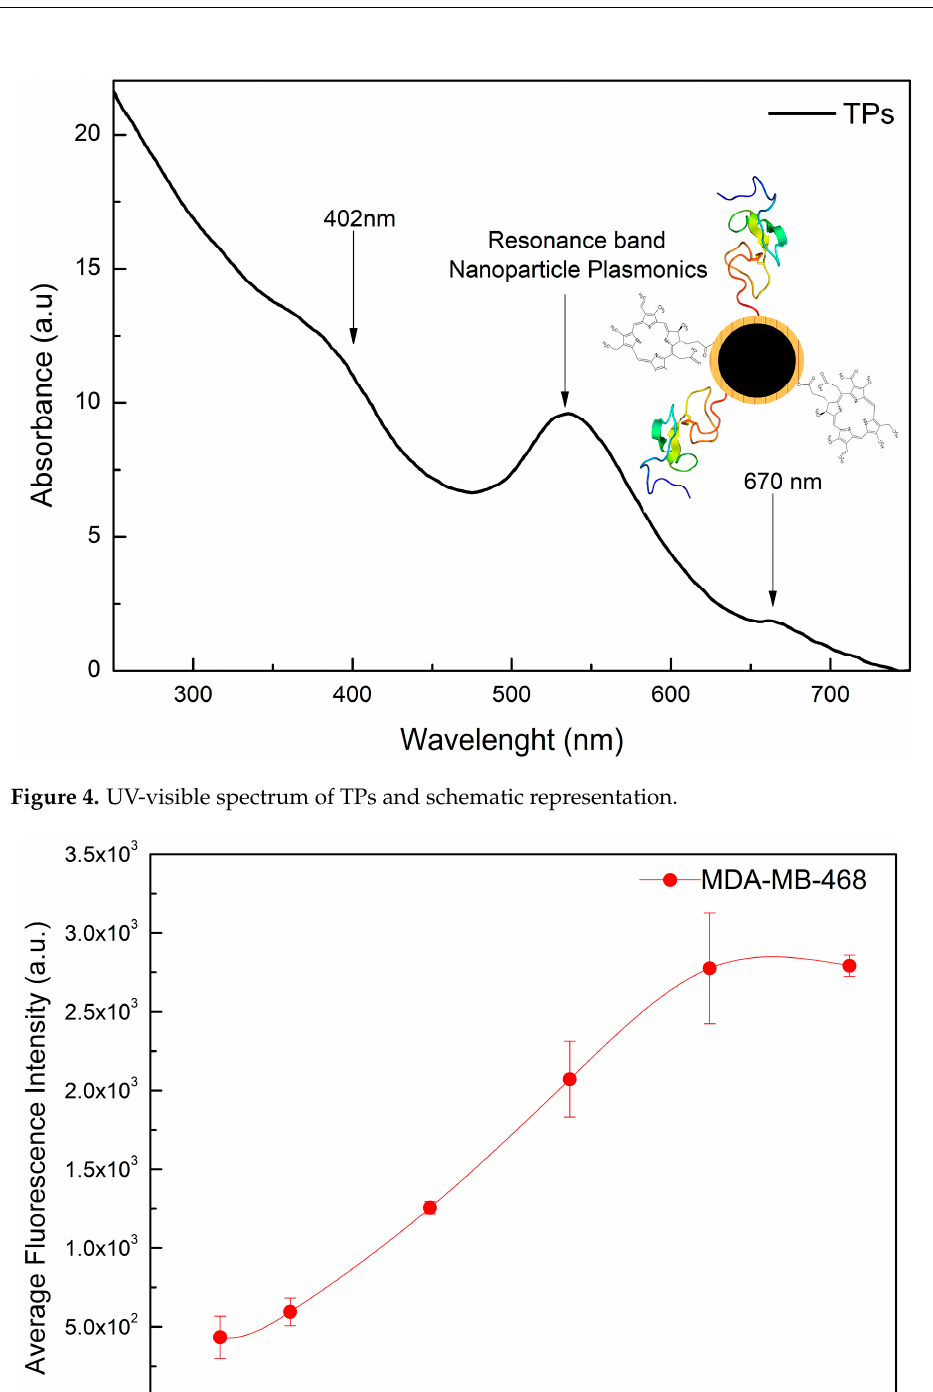
Figure 5. Analysis of the time of incorporation of TPs in the MDA-MB-468 cell line, with incubation times of 30, 60, 120, 180, 240, and 300 min.